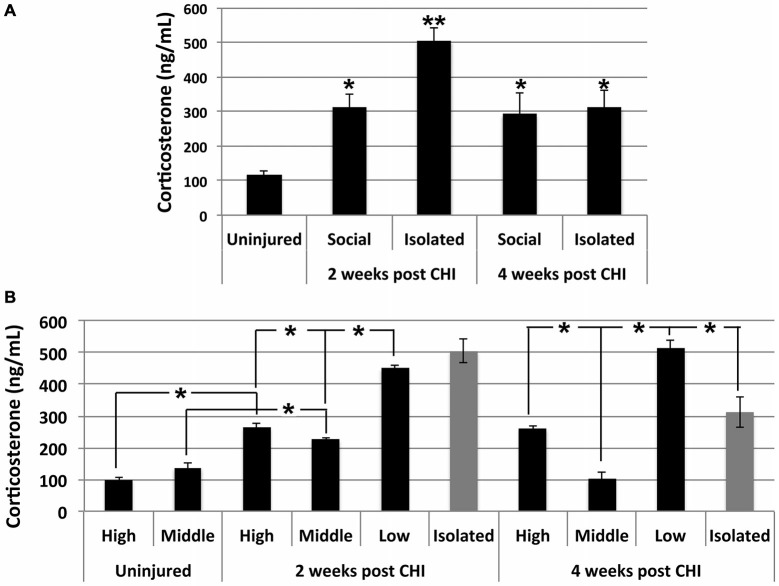
CHI increased corticosterone levels in serum; exacerbation by isolation and social hierarchy. (A) Serum corticosterone increased significantly in socially-housed and isolated mice at 2 and 4 weeks following CHI (p < 0.02; single asterisk). An additional significant increase was observed for isolated mice at 2 weeks following CHI vs. isolated mice at 4 weeks post CHI and socially-housed mice at both 2 and 4 weeks following CHI (p < 0.02; double asterisk). (B) Socially-housed mice were ranked according to the extent of aggressive behavior as high, middle and low as described in the text. High and low ranked mice subjected to CHI displayed significantly increased corticosterone vs. from uninjured high and low ranked mice, respectively (p < 0.02); note that uninjured mice were housed in duplicate, and therefore there is no middle rank for uninjured mice. Corticosterone levels in mice subjected to CHI were significantly higher in low rank mice than high and middle rank mice; levels in high rank mice were significantly higher than middle rank mice, and levels in middle ranked mice differed significantly from both highest and lowest ranked mice (p < 0.02). Low rank mice displayed corticosterone levels statistically identical to those of mice housed in isolation at 2 weeks and more elevated (p < 0.02); than those of mice housed in isolation at 4 weeks post CHI. Values represent the mean ± standard error from 3 homogenates (each assayed in duplicate) each from mice subjected to CHI and 2 homogenates each from mice not subjected to CHI (uninjured); asterisks indicate significant differences.